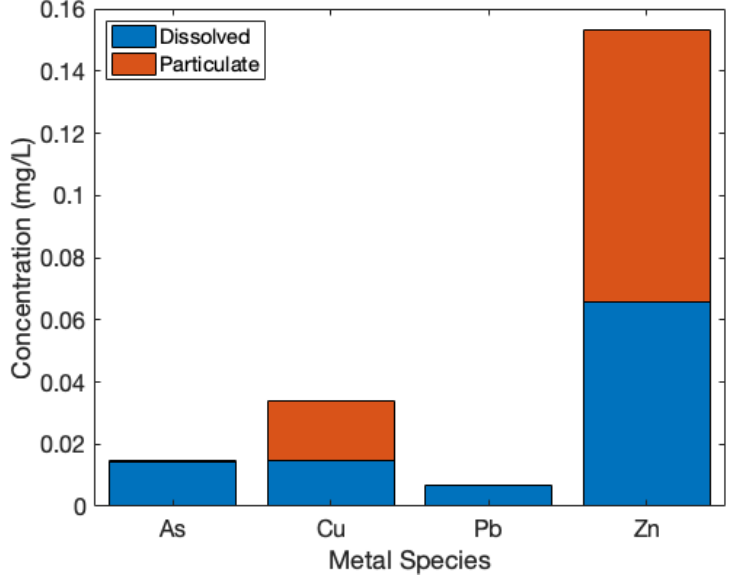
Figure A6. Distribution bar plot of dissolved and particulate-associated metals concentrations.